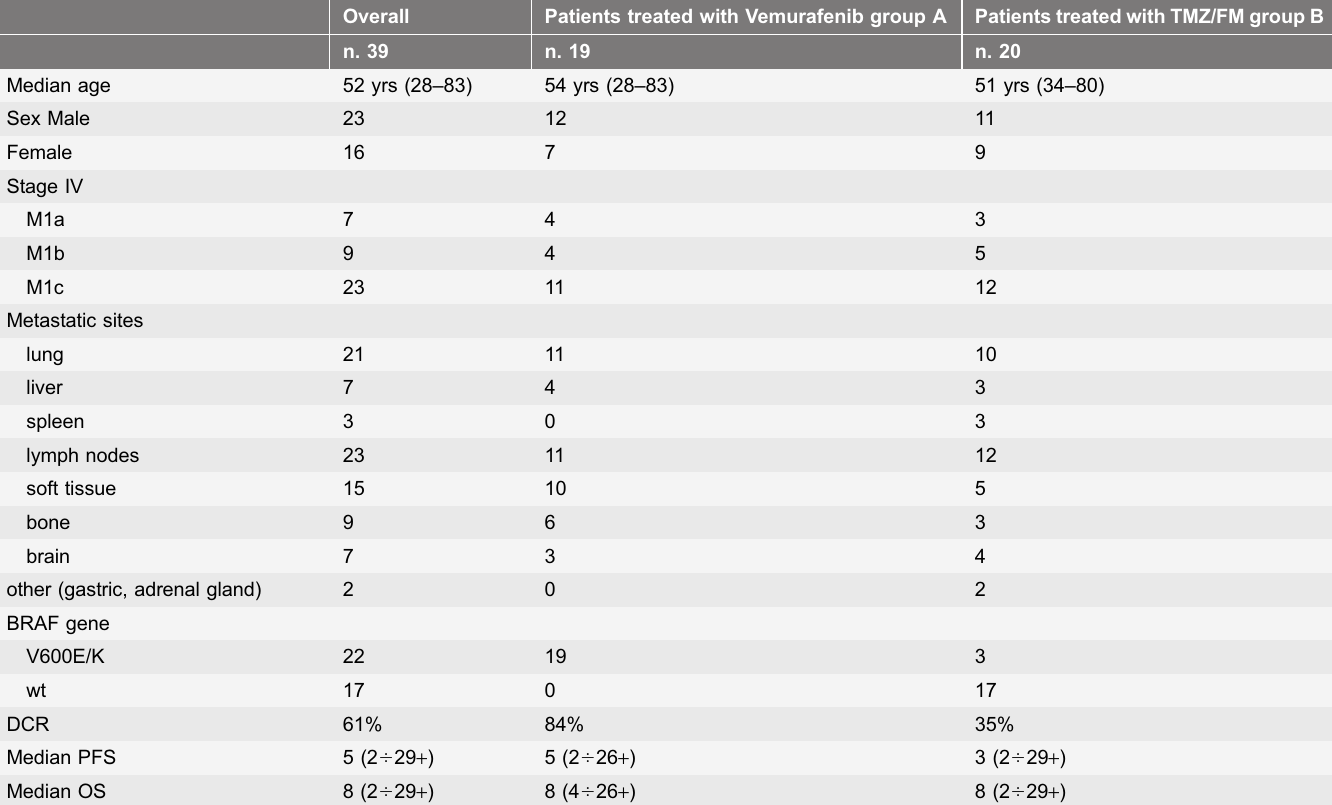
Table 1. Patient